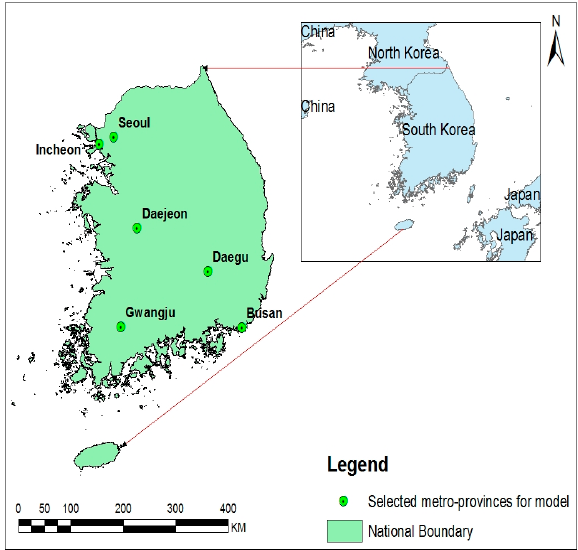
Figure 1. Map of geographical areas of Korea showing the six metropolitan provinces studied for model. The left panel shows the study sites in Korea map, and the right panel highlights the location of Korea in Asia.